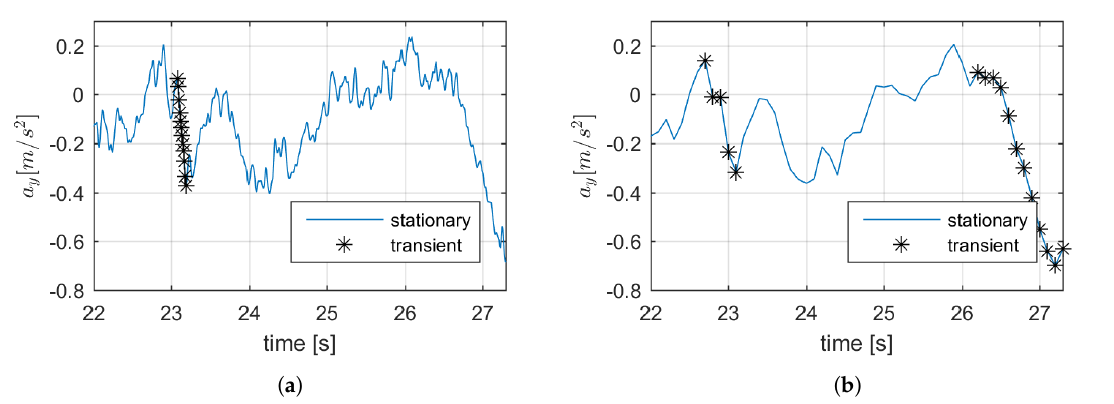
Figure 11. Comparison of the ability to separate transient segments in different sample rates: ( a ) Lateral acceleration a y vs time with a sample rate of 100 Hz. ( b ) Lateral acceleration a y vs time after downsampling to 10